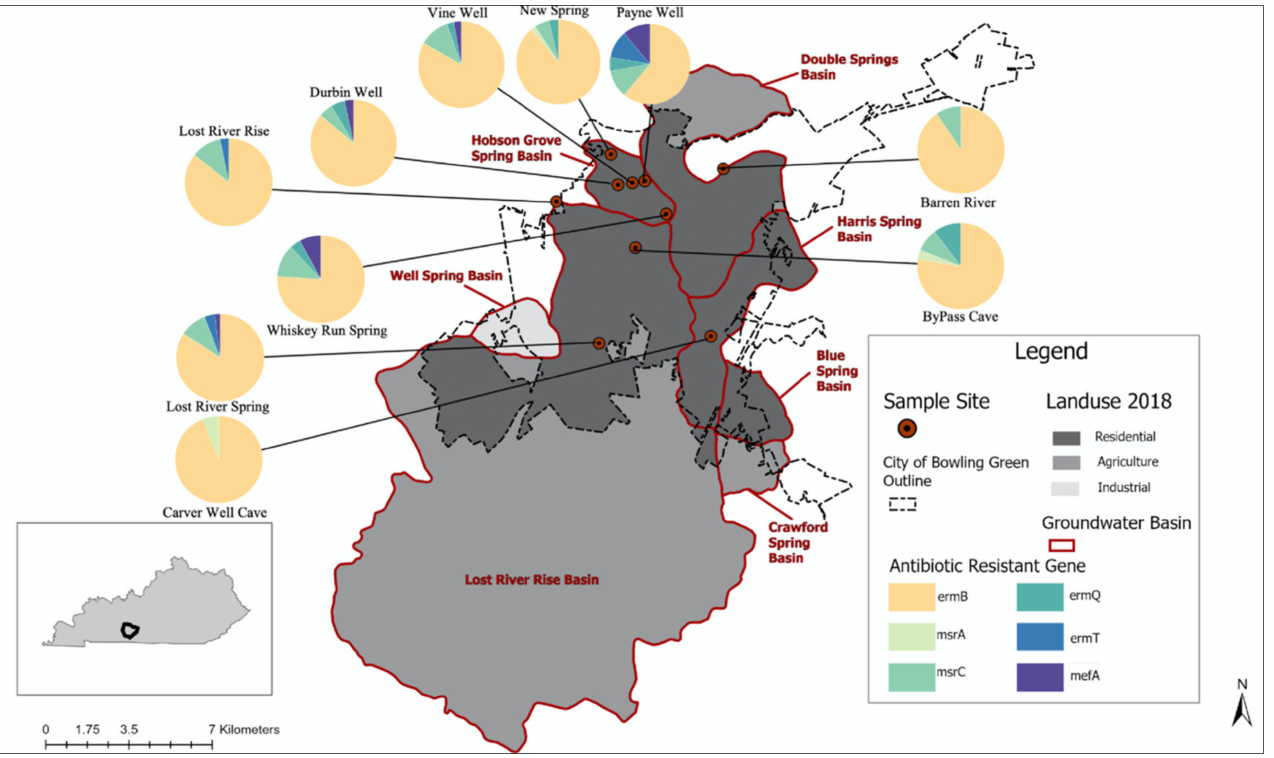
Figure 5. Spatially represented macrolide ARG detection frequency associated with resistance phenotypes for Enterococcus spp. and landuse in Bowling Green, KY urban karst